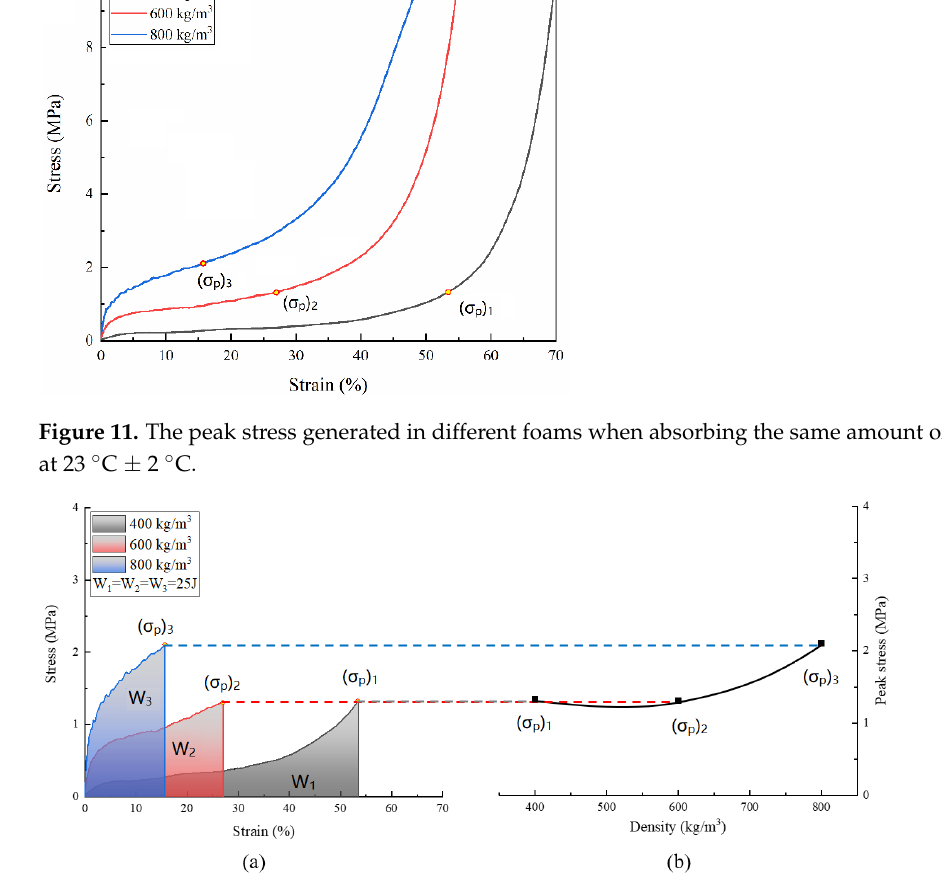
Figure 12. Energy-absorption diagram: ( a ) detailed stress–strain curves; ( b ) peak stress variation depending on the density.